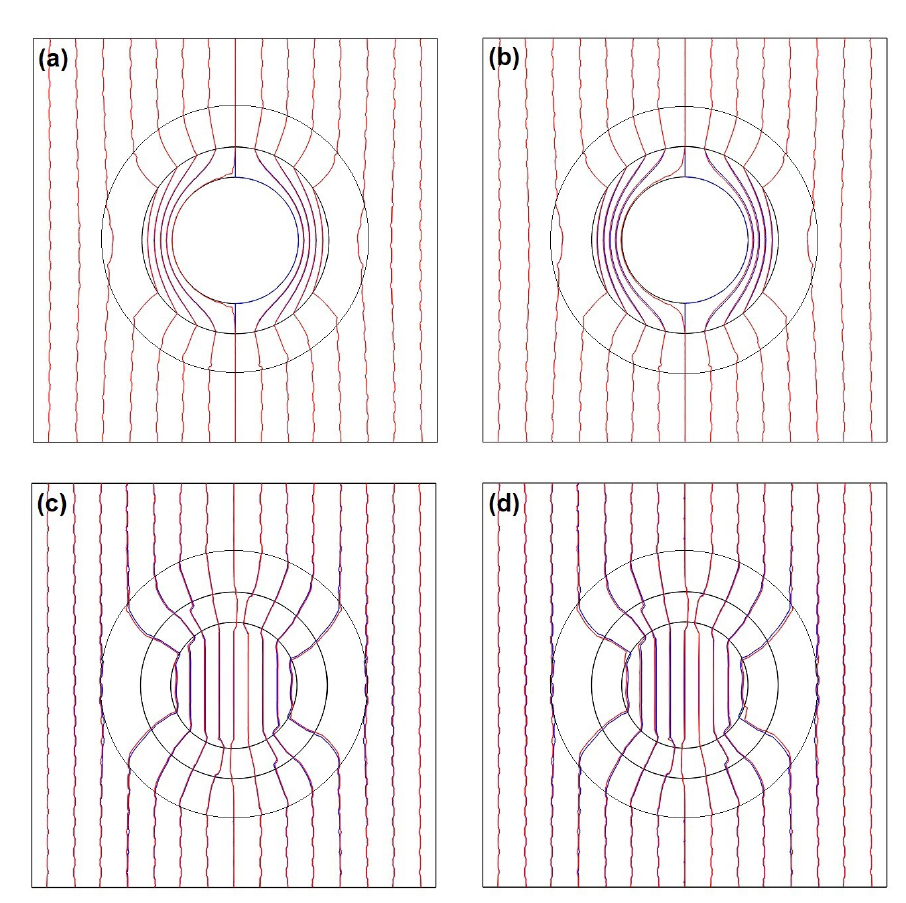
Figure 5. Finite-element simulation results: Equipotential lines of both voltage and temperature. The blue lines denote the electrical equipotential lines and the red lines denote the isothermal lines. The electrical potential difference between the two boundaries of the device is set as 1 V, so the blue lines will not distort as the temperature is enhanced, and can be seem as invariant references. ( a ) the cloak state at the temperature 50 K; ( b ) the cloak state at the temperature 200 K; ( c ) the concentrator state at the temperature 50 K; ( d ) the concentrator state at the temperature 200